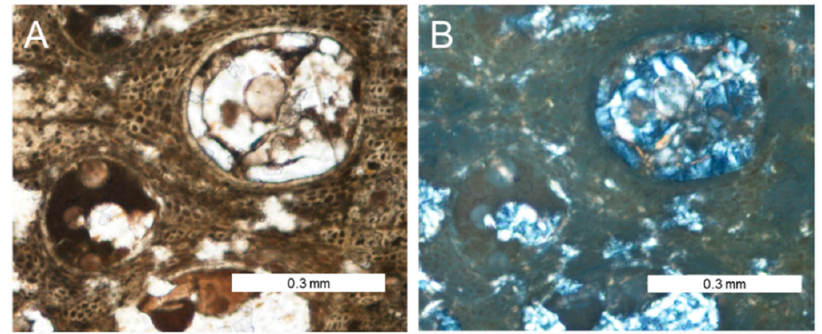
Figure 8. Petrographic thin sections of the transverse plane. ( A ) Vessels surrounded by cellular tissue in plain light illumination and ( B ) in cross-polarized light illumination.